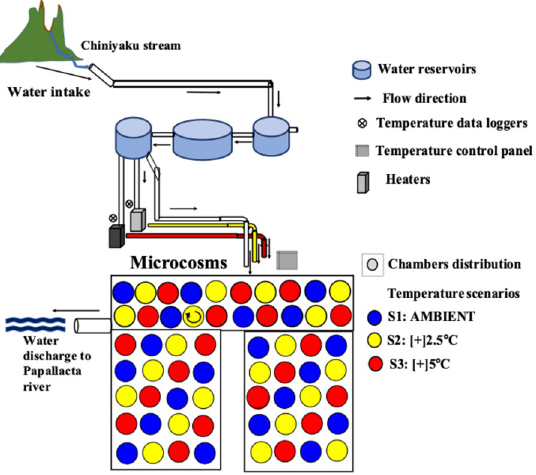
Fig 1. Microcosm. Diagram of the experimental facility from Laboratorio de Ecologı´a Acua´tica (LEA), Universidad San Francisco de Quito (USFQ), located in Papallacta, Ecuador.